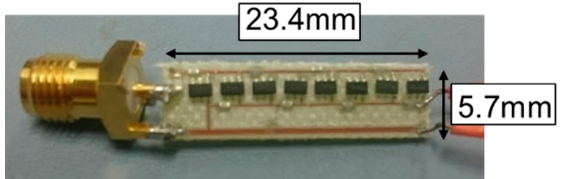
Figure 7. Photograph of the re-fabricated circuit.